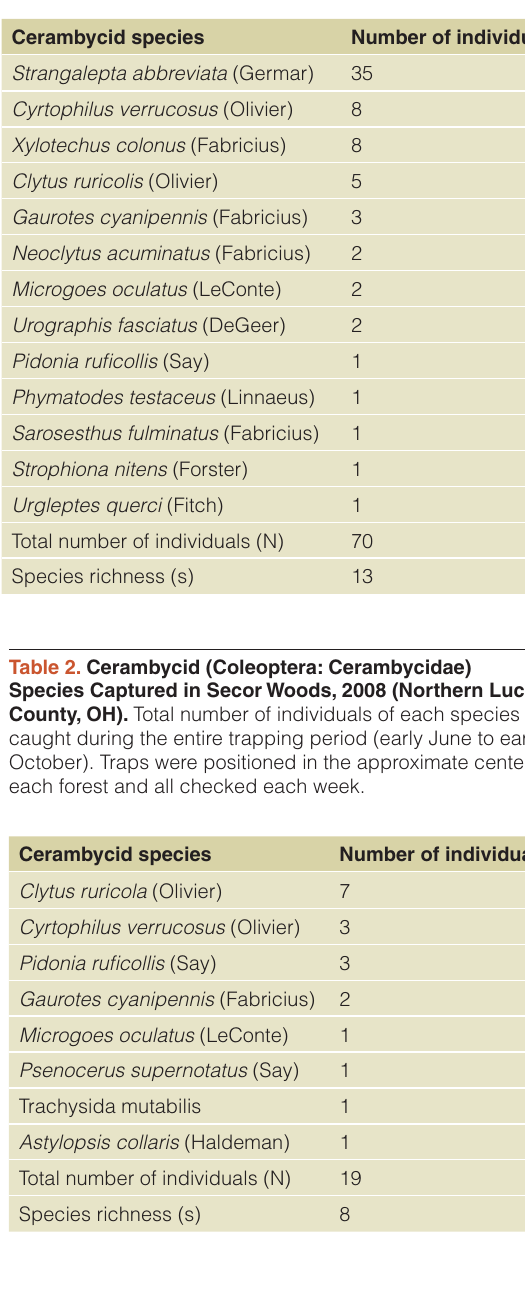
Table 3. Cerambycid (Coleoptera: Cerambycidae) Species Captured in Wildwood Preserve, 2008 (Northern Lucas County, OH). Total number of individuals of each species caught during the entire trapping period (early June to early October). Traps were positioned in the approximate center of each forest and all checked each week.